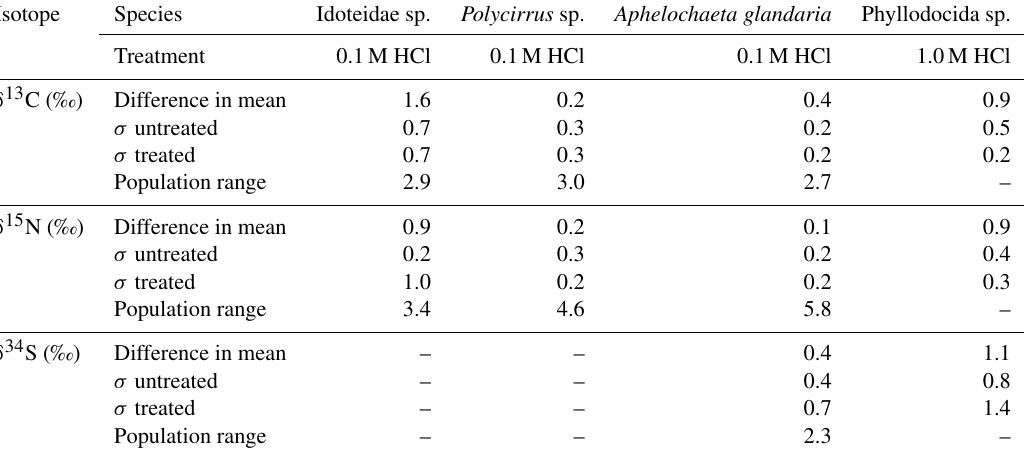
Table 2. Differences in isotopic values and standard deviation ( σ) of ethanol-preserved fauna sampled during JC55 in response to acid treatment compared with population ranges of untreated samples. The Phyllodocida sp. was a single large specimen used only as part of preliminary experiments. Data rounded to 1dp to account for measurement